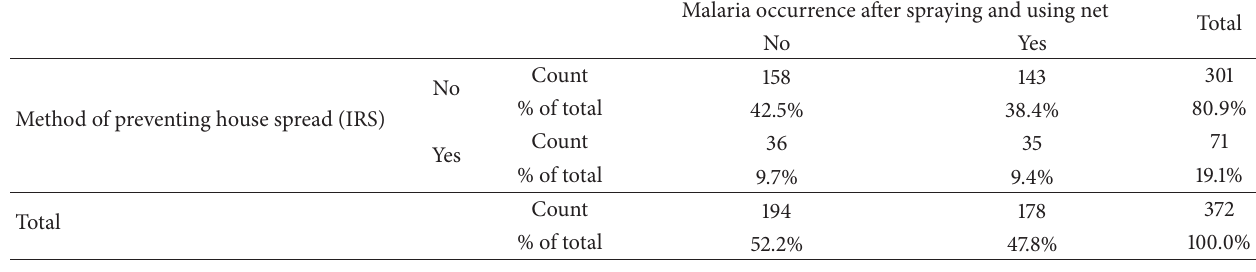
Table 9: Method of preventing malaria house sprayed IRS (malaria occurrence after spraying and using net cross tabulation).